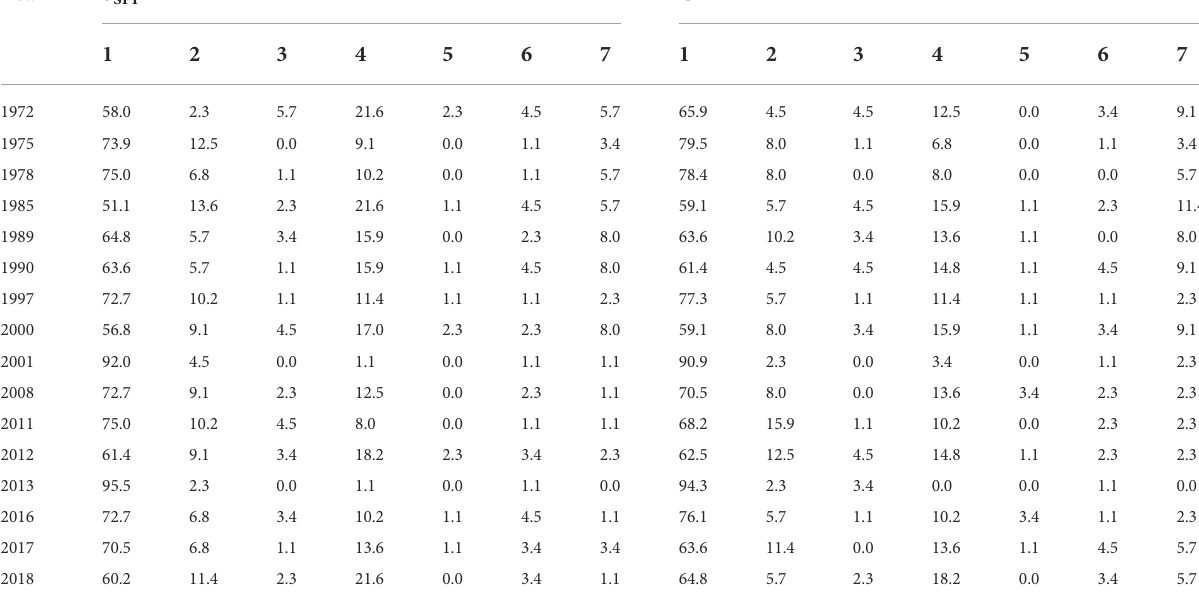
TABLE 3 Comparison of station ratio in extreme fl oods year in the whole year